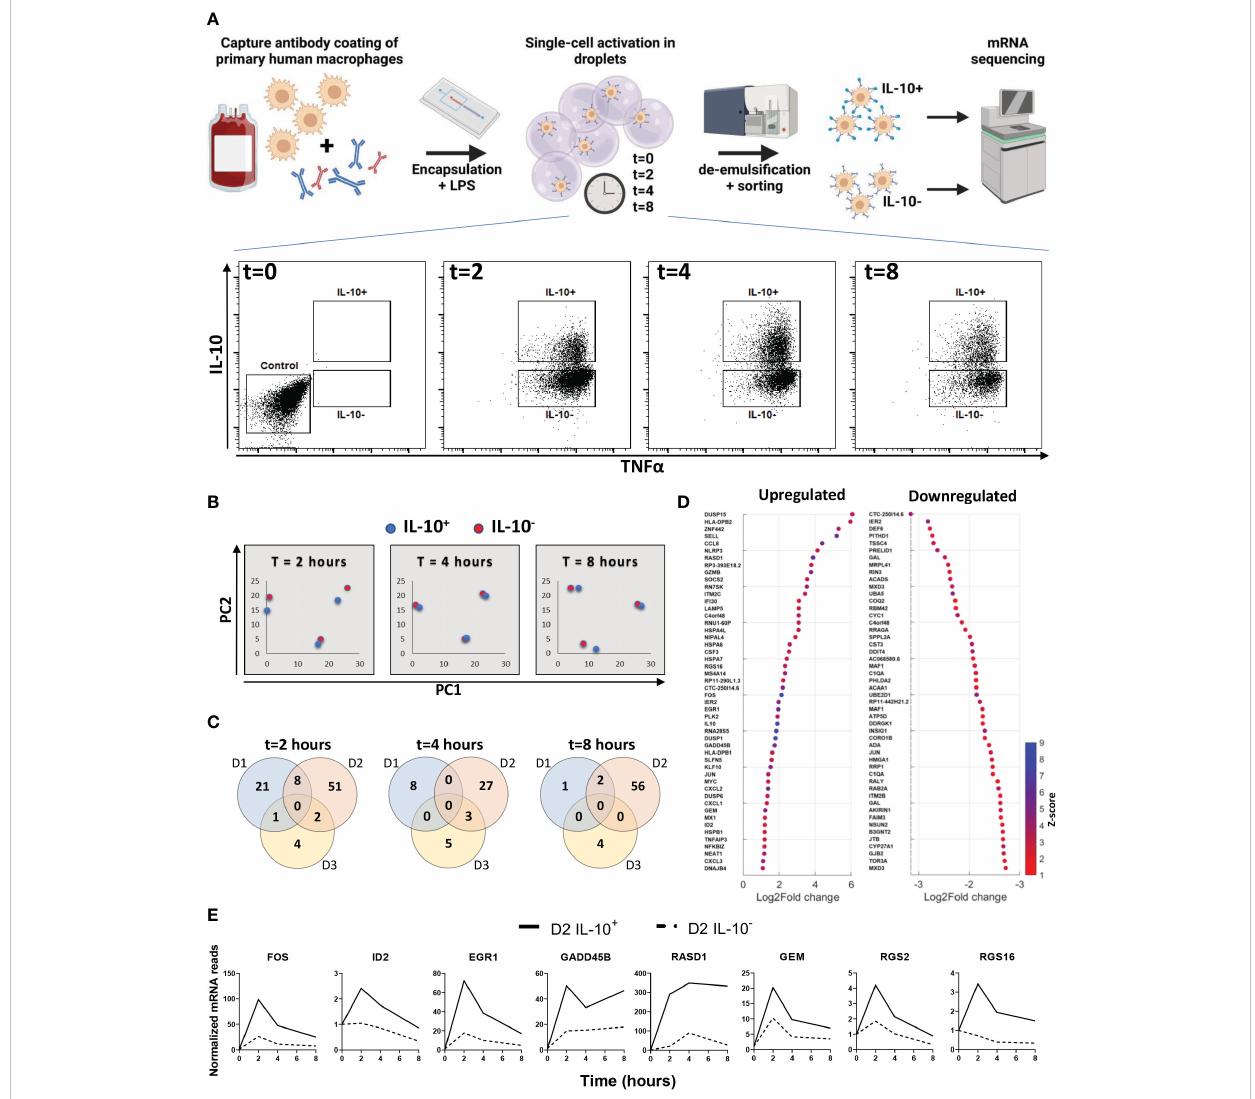
FIGURE 2 Transcriptional analysis of IL-10 positive and IL-10 negative macrophages. (A) experimental work fl ow; primary macrophages are coated with cytokine capture antibody and encapsulated in droplets with LPS. After 0, 2, 4 and 8 hours of stimulation cells are sorted into IL-10 producing and IL-10 non-producing populations. From each population mRNA is isolated and sequenced. (B) Principal component plot of IL10+ (blue dots) and IL10- (red dots) condition for all three timepoints and all three donors separate. (C) Venn diagrams showing the number of differentially upregulated genes per donor for every timepoint. (D) Top 50 log2fold upregulated differentially expressed genes for all donors over all timepoints. (E) Genes of interest upregulated in the IL-10+ sorted cells of donor 2 as expressed over